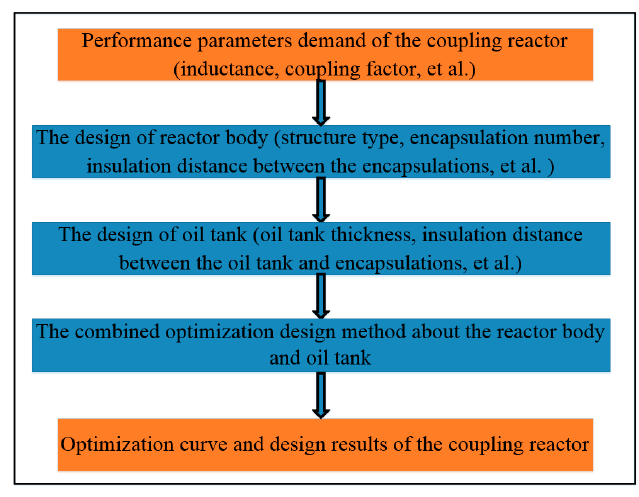
Figure 14. The overall optimization flow chart.